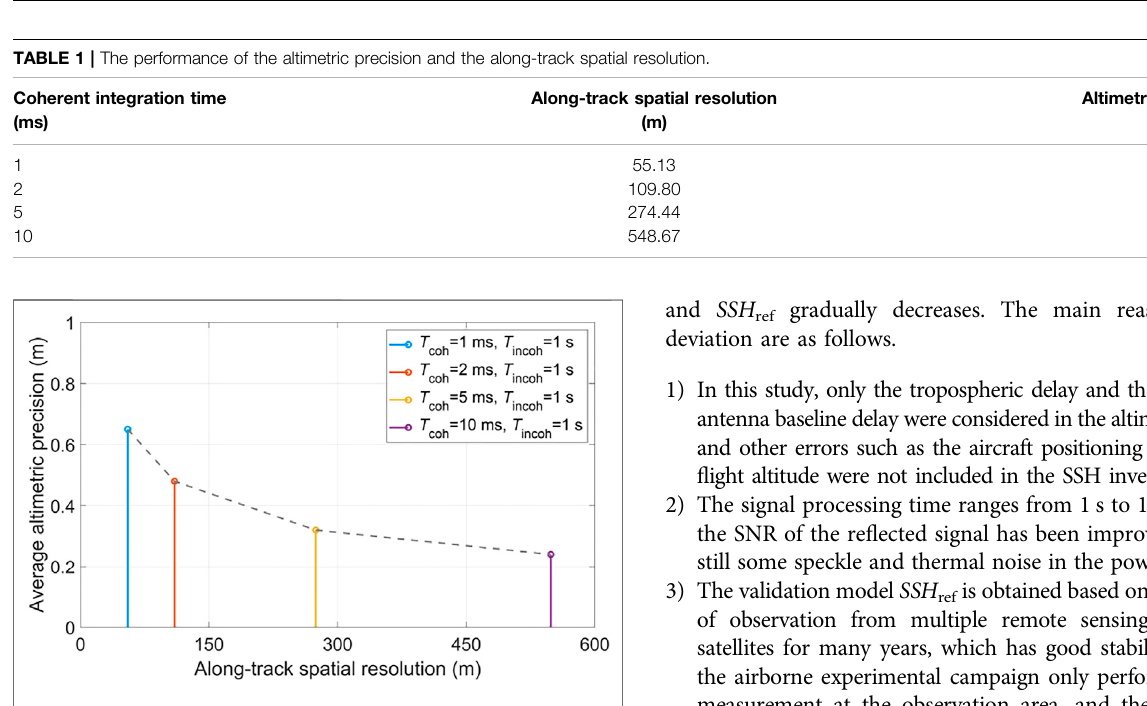
FIGURE 6 | Altimetric precision as a function of along-track spatial resolution under airborne scene.